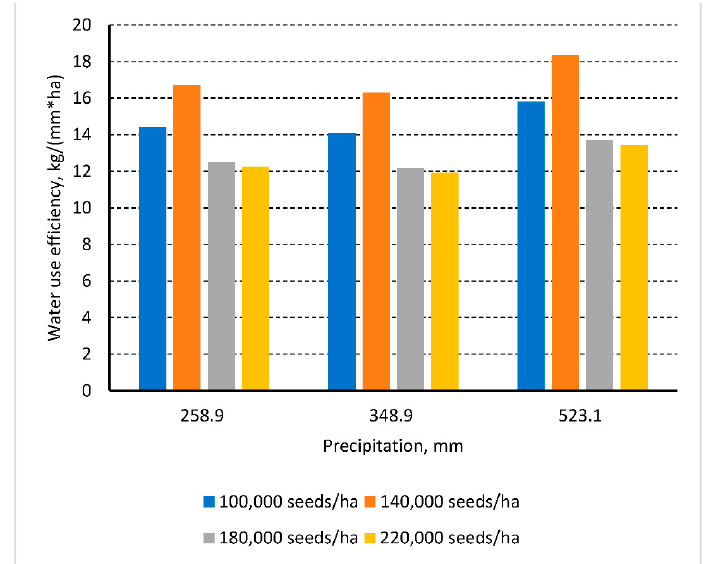
Figure 10. Water use efficiency for sweet sorghum.